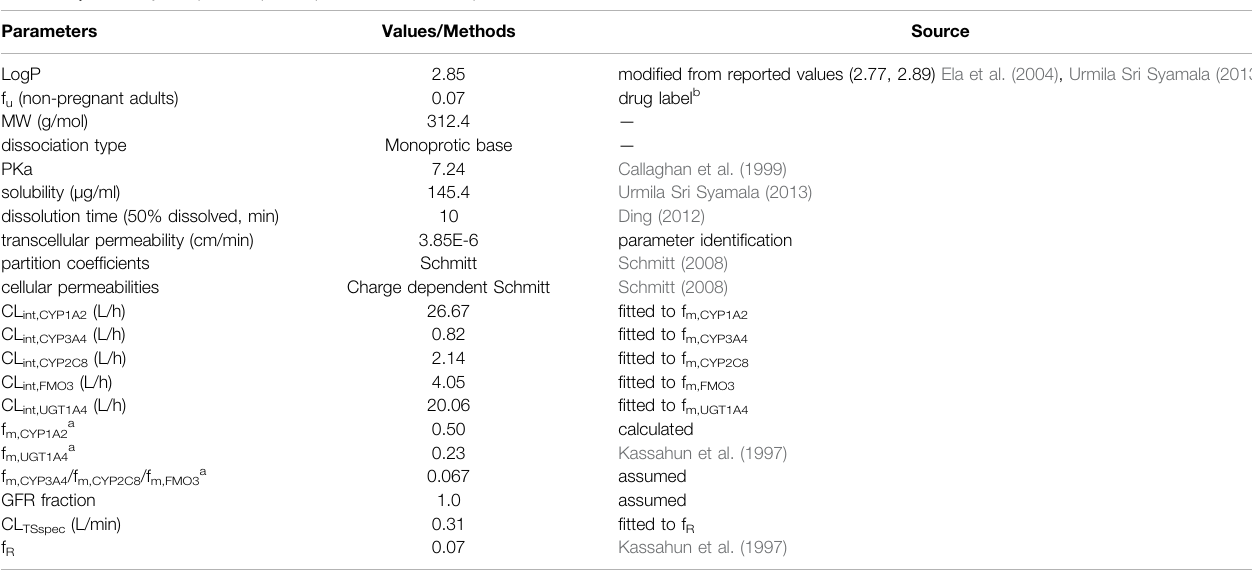
TABLE 1 | Summary of input compound parameters of olanzapine PBPK model.